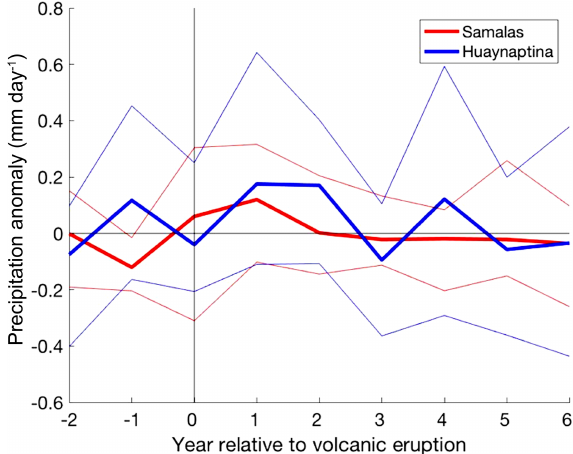
Figure 12. Mean SE Australian precipitation (mmday − 1 ) response of all volcanic ensembles (four CR ensembles and one 2 × G en- semble) to the largest (1258 Samalas) and smallest (1600 Huayna- putina) eruptions analysed over JASON. The bold lines represent the mean of all volcanic ensembles to each eruption, and the fainter lines represent the 90th and 10th percentile of the ensemble mem-